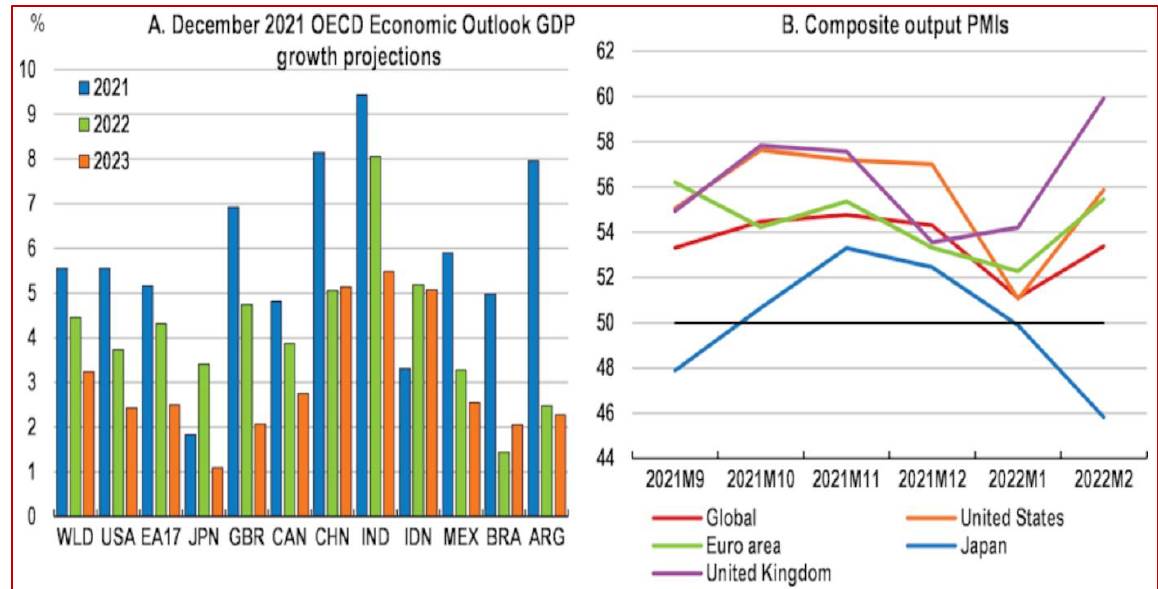
Figure 2. Economic and Social Impacts and Policy Implications of the War in Ukraine OECD Economic Outlook, Interim Report March 2022 (oecd-ilibrary.org; accessed on 23 July 2022).